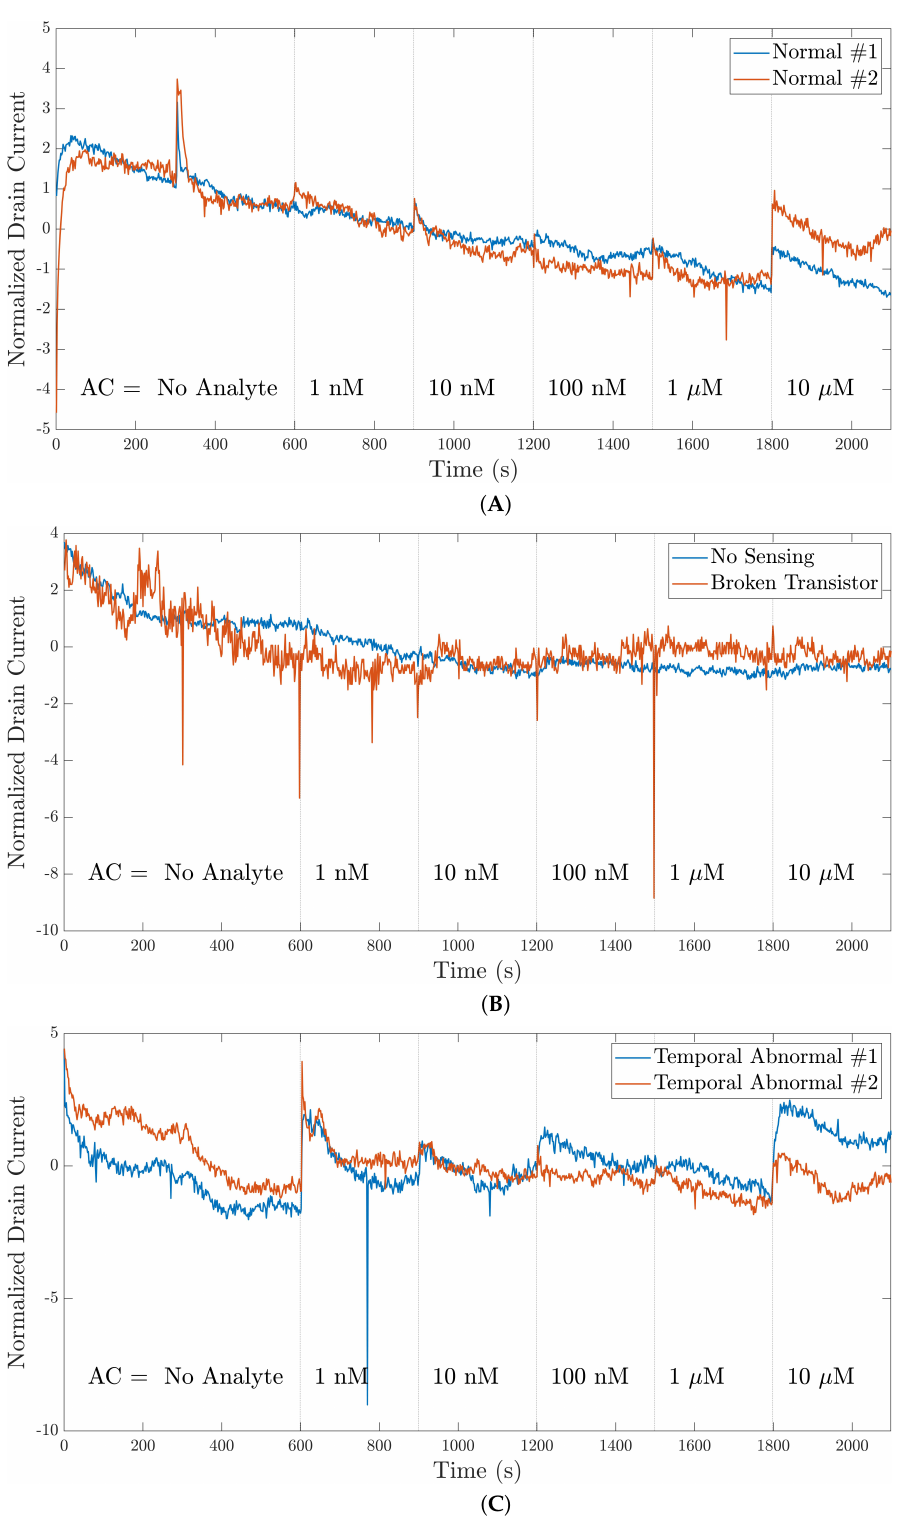
Figure 7. The plots compare the normal behavior in the 35-mer oestradiol signals with the behavior of the contextual outliers: ( A ) signals with normal patterns; ( B ) signals with contextual outliers (the red and blue lines in the plot represent signals generated by non-sensing and broken transistor devices, respectively); ( C ) abnormal temporal signals that were registered with normal sensors but showed unusual behavior between 300 and 750